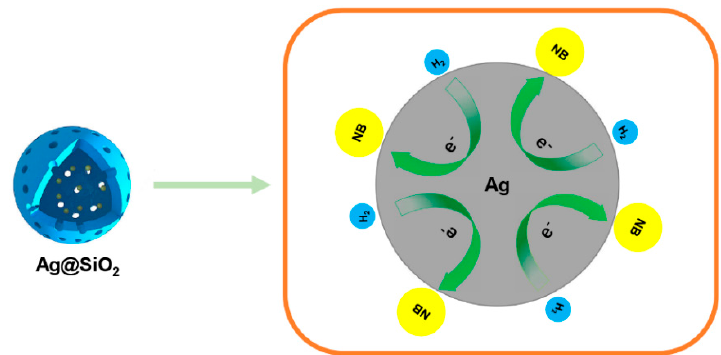
Figure 10. Schematic explanation of the catalytic process occurring on the nanoparticles during the reaction.